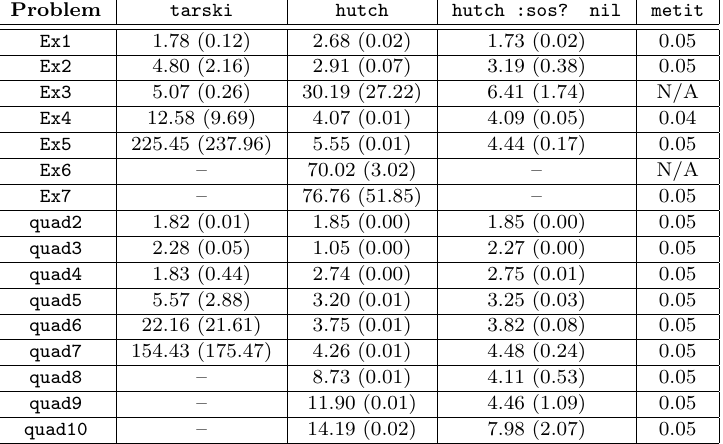
Table I. Comparison between tarski vs. hutch (with flag sos? enabled and disabled) which mainly involves simple symbolic checks, takes a significant percentage of the